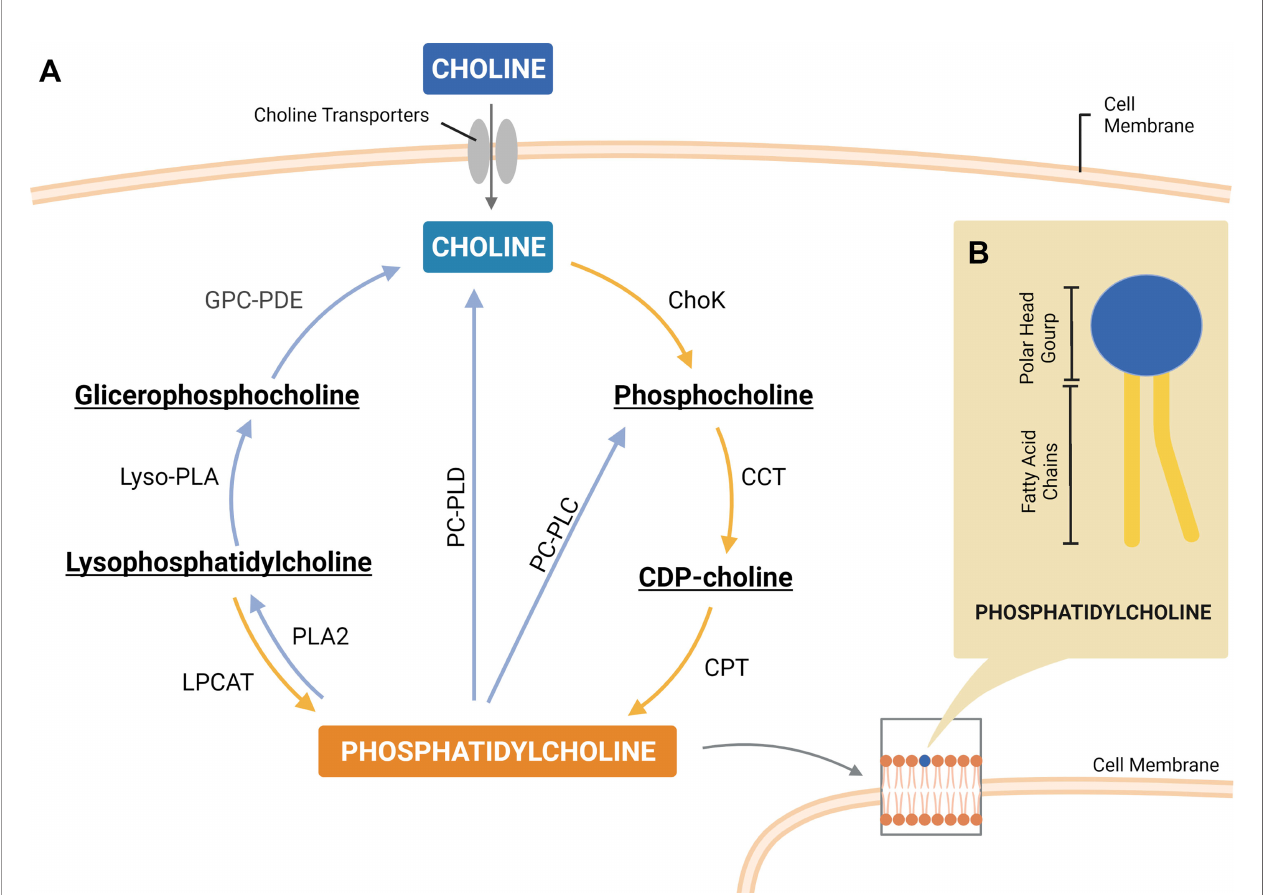
FIGURE 2 | A simpli fi ed scheme of the phosphatidylcholine (PtdCho) cycle, highlighting the enzymes involved in PtdCho synthesis (Kennedy pathway) and catabolism (A) . Representative structure of PtdCho consisted of a choline head group and a phosphate group (polar head group) linked to two fatty acid chains by a glycerol moiety (B) . ChoK, choline kinase; CCT, CTP:phosphocholine cytidylyltransferase; CPT, CDP-choline cholinetransferase; LPCAT, lysophosphatidylcholine acyltransferase; PLA2, phospholipase A2; PC-PLC, phosphatidylcholine-speci fi c phospholipase C; PC-PLD, phosphatidylcholine-speci fi c phospholipase D; lyso-PLA, lysophospholipase; GPC-PDE, glycerophosphocholine phosphodiesterase. Created with